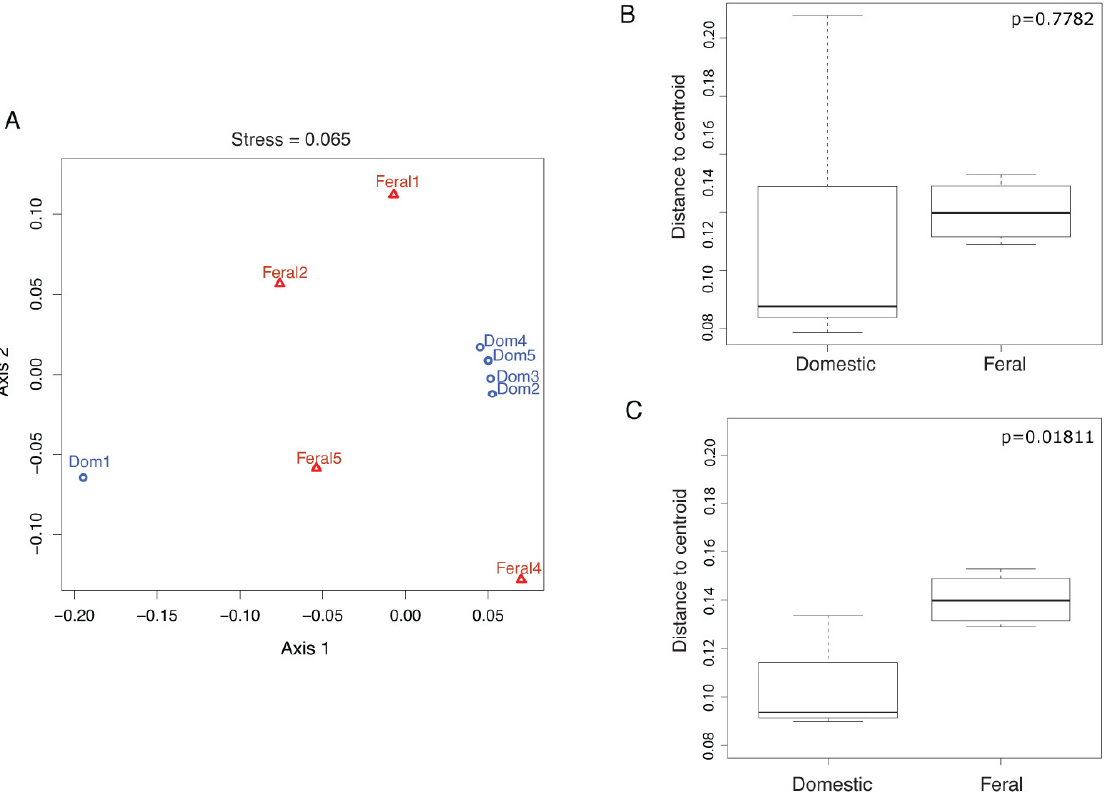
Figure 2. Bacterial Community Structure. ( A ) Non-metric multidimensional scaling (NMDS) of community structure in feral and domesticated goats at the PhyloChip-OTU- level; blue circles represent the domestic animals, while red triangles represent feral goats. The stress value is presented as a metaMDS stress. ( B ) Analyses of dispersion for the communities within each animal group. ( C ) Analyses of dispersion for each goat group without the domestic outlier